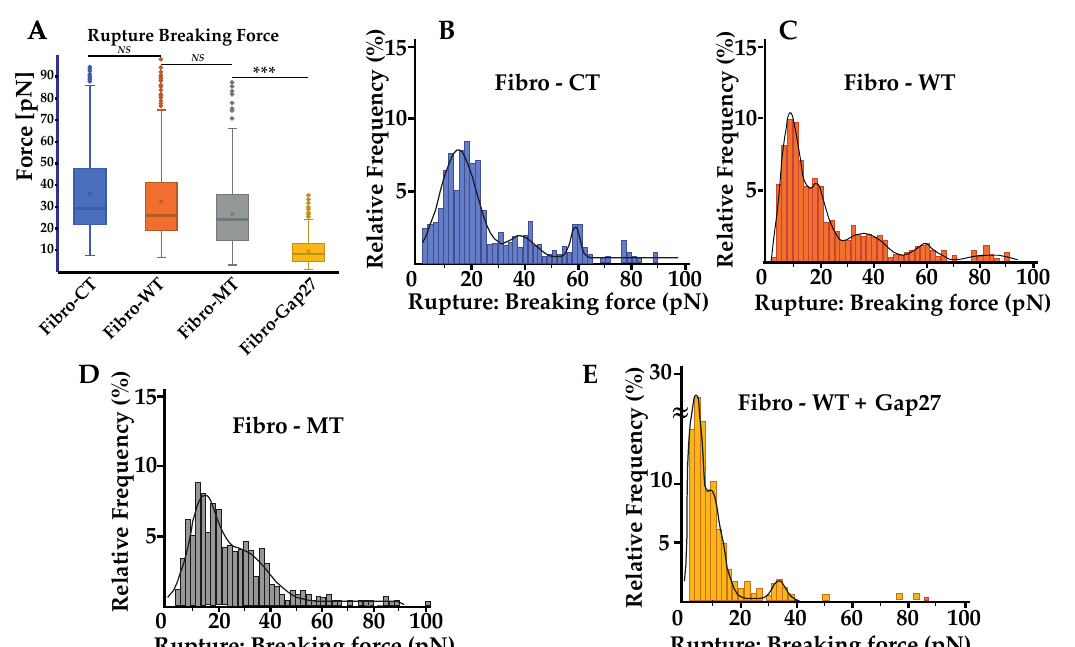
Figure 5. Rupture pattern obtain using the AFM. ( A ) Comparison of rupture pattern between control, wild type, LMNA D192G mutation, and NRVFs WT incubate with Gap27 (Fibro-WT + Gap 27). Rupture breaking force is the force applied to break the link between the adhesion proteins of two cells in contact during the “short distance (0 to 5 µm)” de-adhesion step. (n Fibro-CT = 152, n Fibro-WT = 221, n Fibro-MT = 177, n Fibro-WT + Gap27 = 122 analyzed curves, respectively). ( B – E ) Rupture breaking force distribution histogram for the different NRVFs conditions. The black curves represent the overall Gaussian fit distributions, (*** p < 0.0001; NS = non-significant).